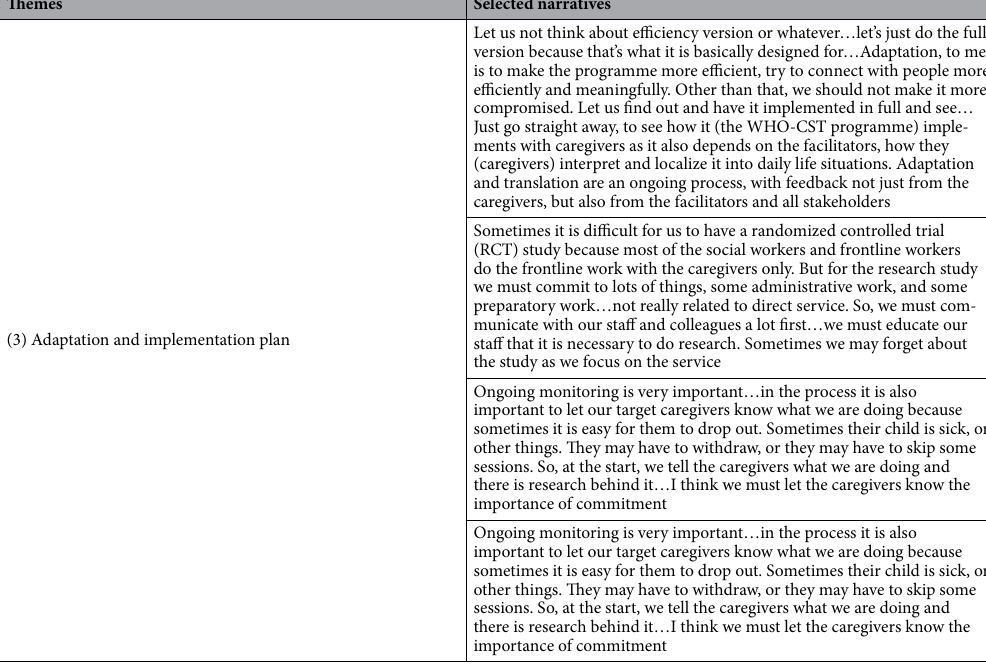
Table 3. Themes and selected narratives of all three adaptation meetings with stakeholders in phase 1 (n =